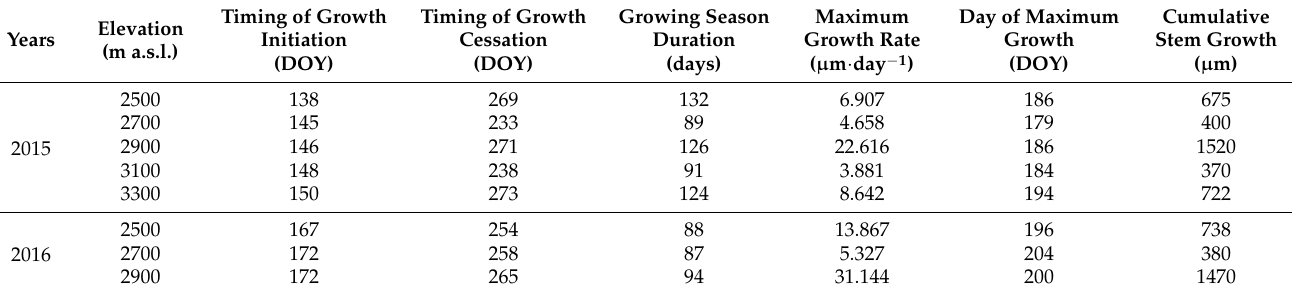
Table 3. Characteristics of seasonal growth patterns at different elevations in 2015 and 2016.